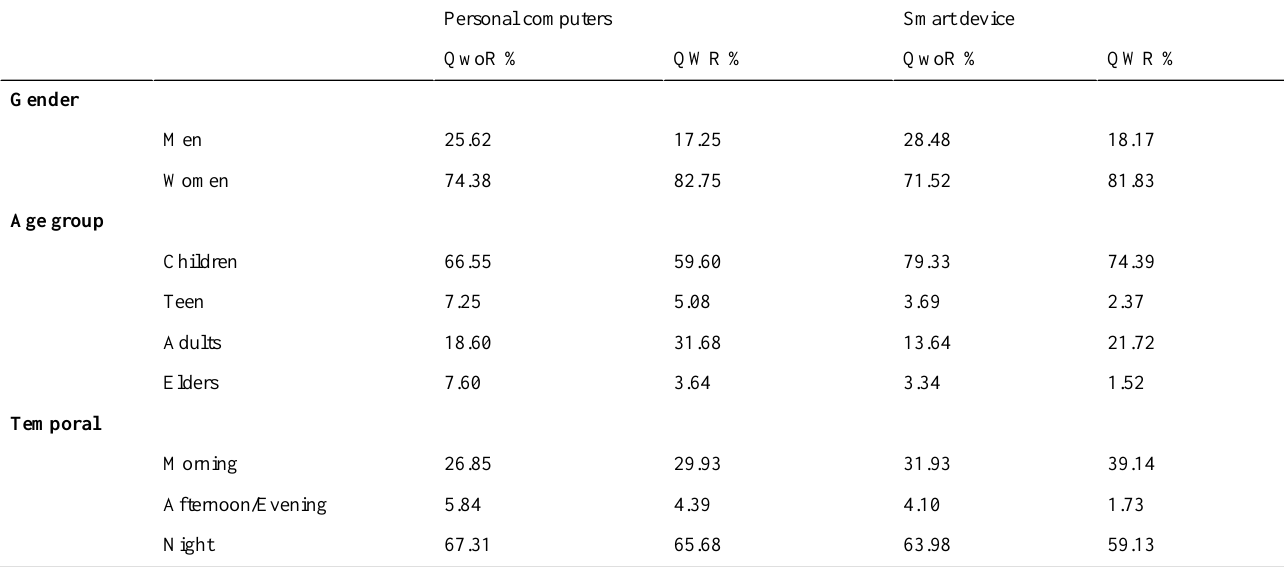
Table 1. Categorization of health search queries based on the information mentioned in the queries such as gender, age group, and temporal information (June 2011-May 2013).